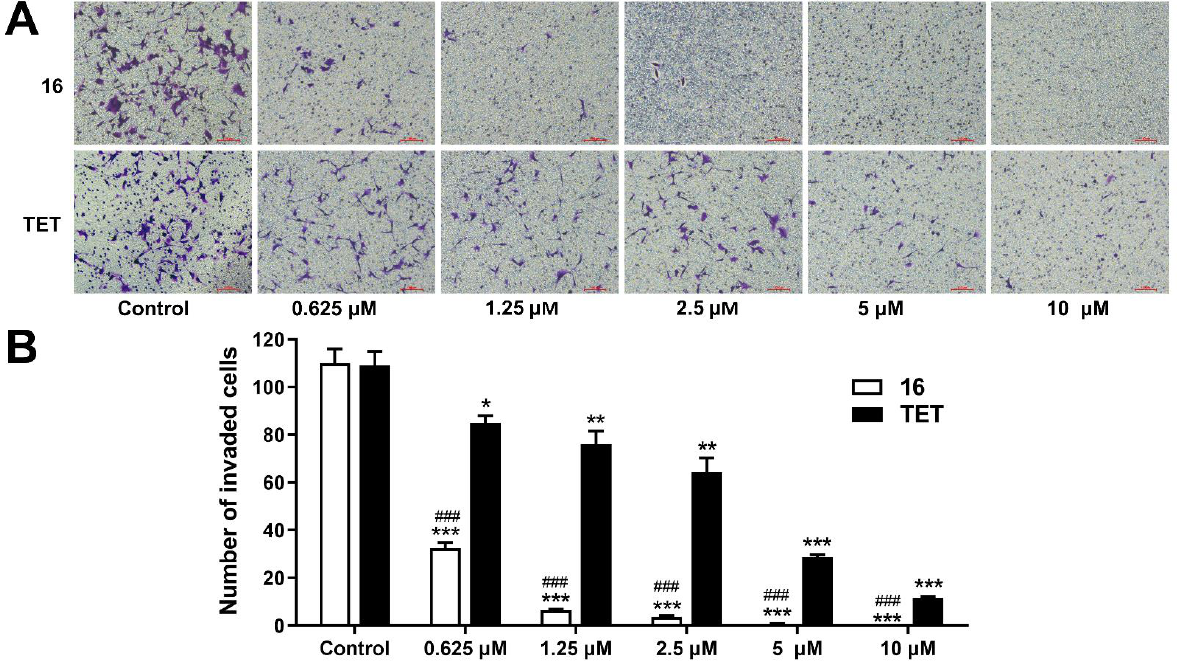
Figure 5. Invasion suppressing effect of 16 against HCT-15 cells by transwell assay. ( A ) Suppressing effect of 16 (0.625, 1.25, 2.5, 5, and 10 μ M) on the invasion of HCT-15 cells. ( B ) Quantitative analysis of invaded cells. *: p < 0.05, **: p < 0.01, ***: p < 0.001, vs. control group; ### : p < 0.001 vs. TET at the same concentration.